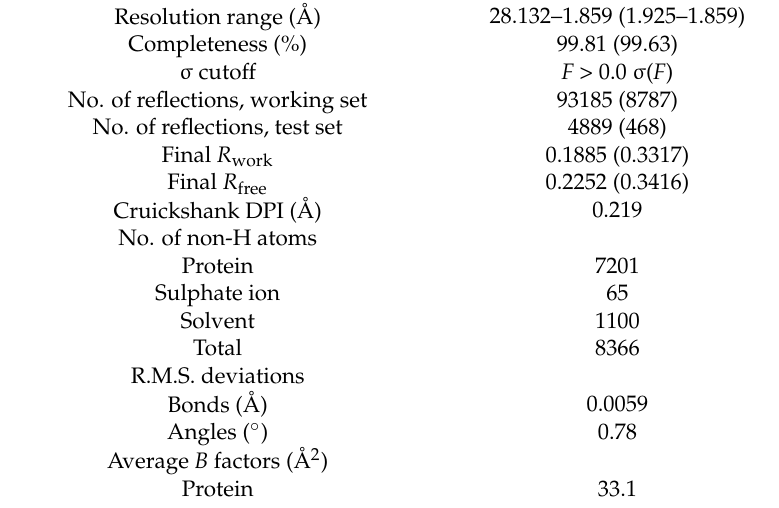
Table 4. Structure solution and refinement. Values for the outer shell are given in